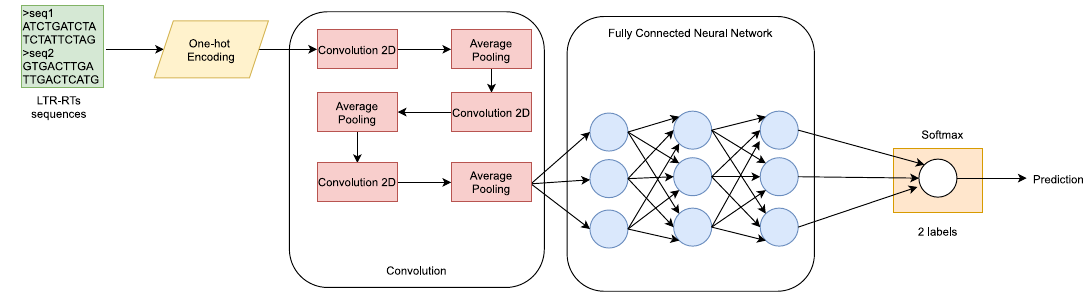
Figure 2: Implementation of the proposed CNN based on TERL